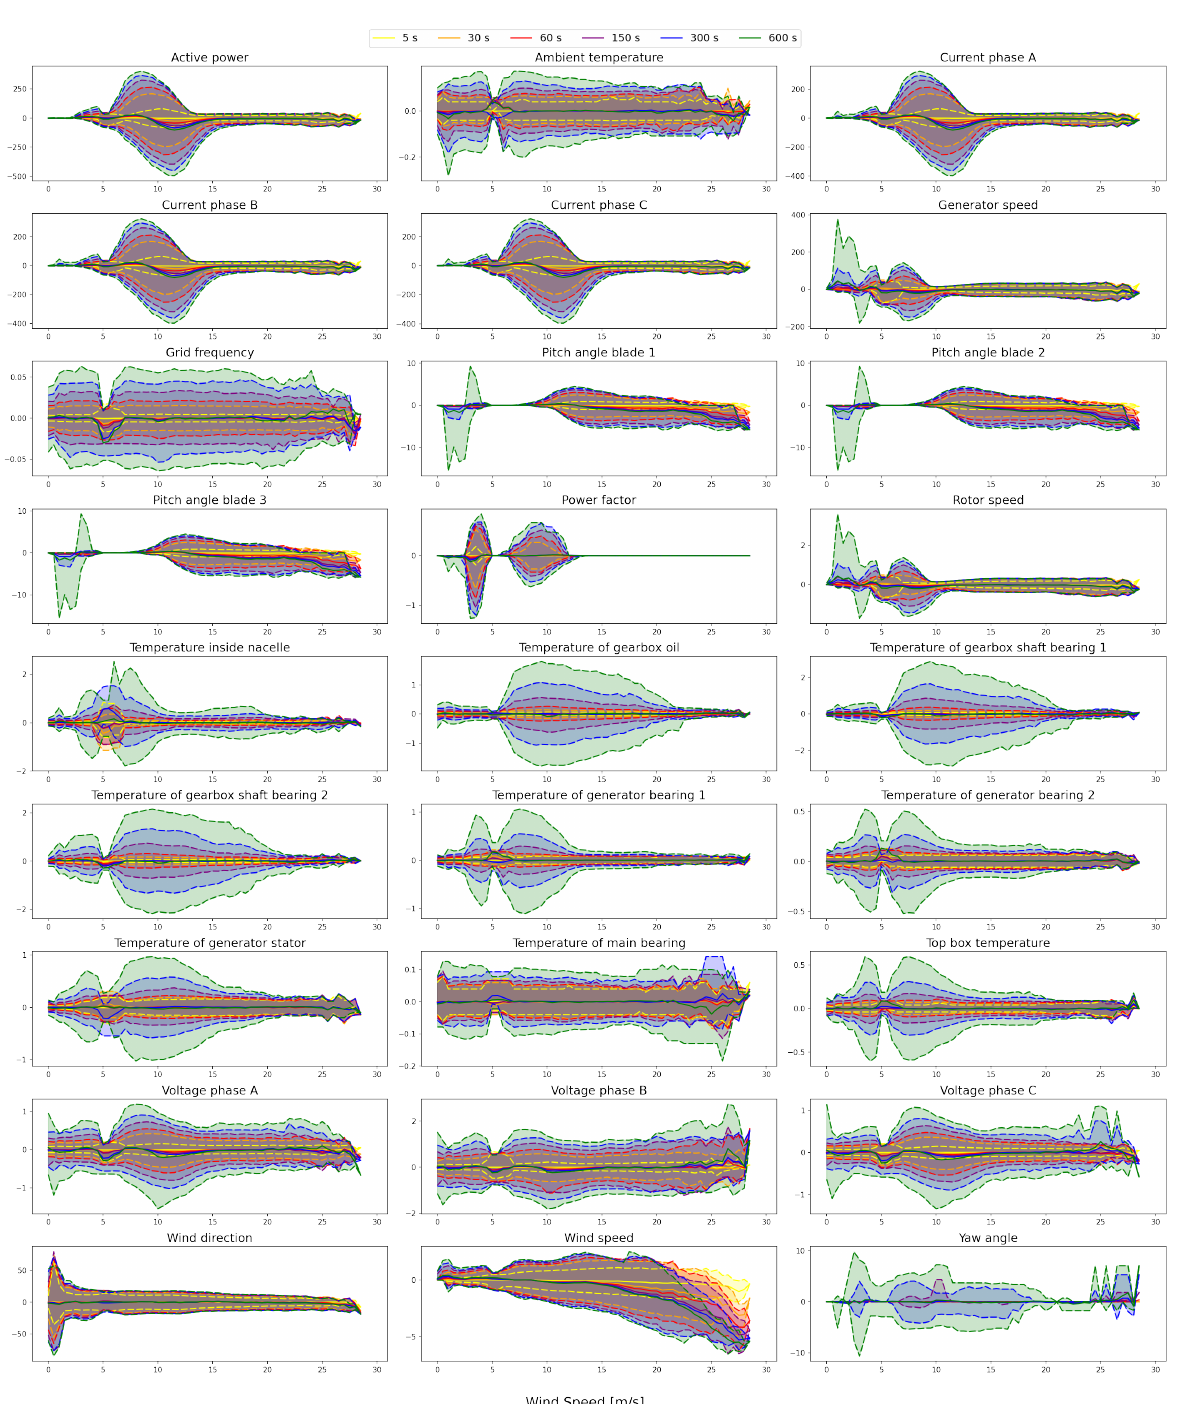
Figure 11. Line plots of the range of variation of information loss for the available signals over wind bins of 0.5m/s width. The lower and upper dash lines represent the 5–95th percentile of the distribution. Solid lines represent mean values. The different colors denote the various aggregation periods that have been analyzed. All signals are not normalized, the y-axes are in natural units. For a less overloaded presentation, the axes do not feature any unit labelling. Please refer to Table 4 for the units of this